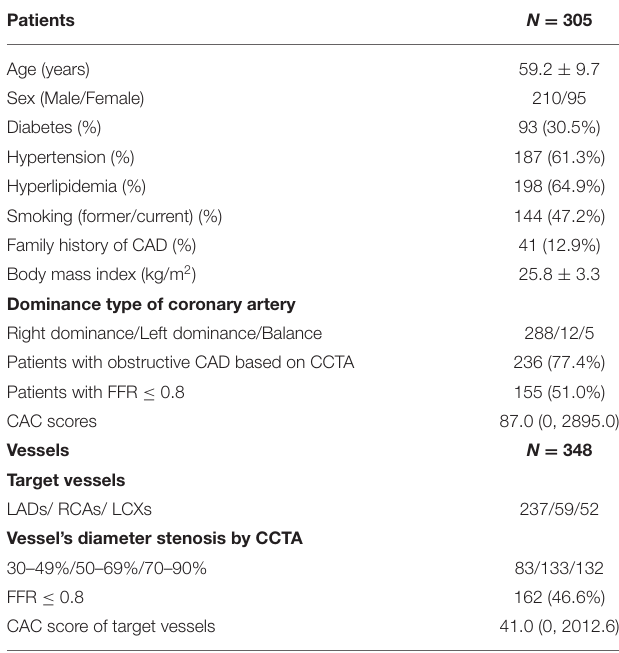
TABLE 1 | Baseline characteristics of patient and